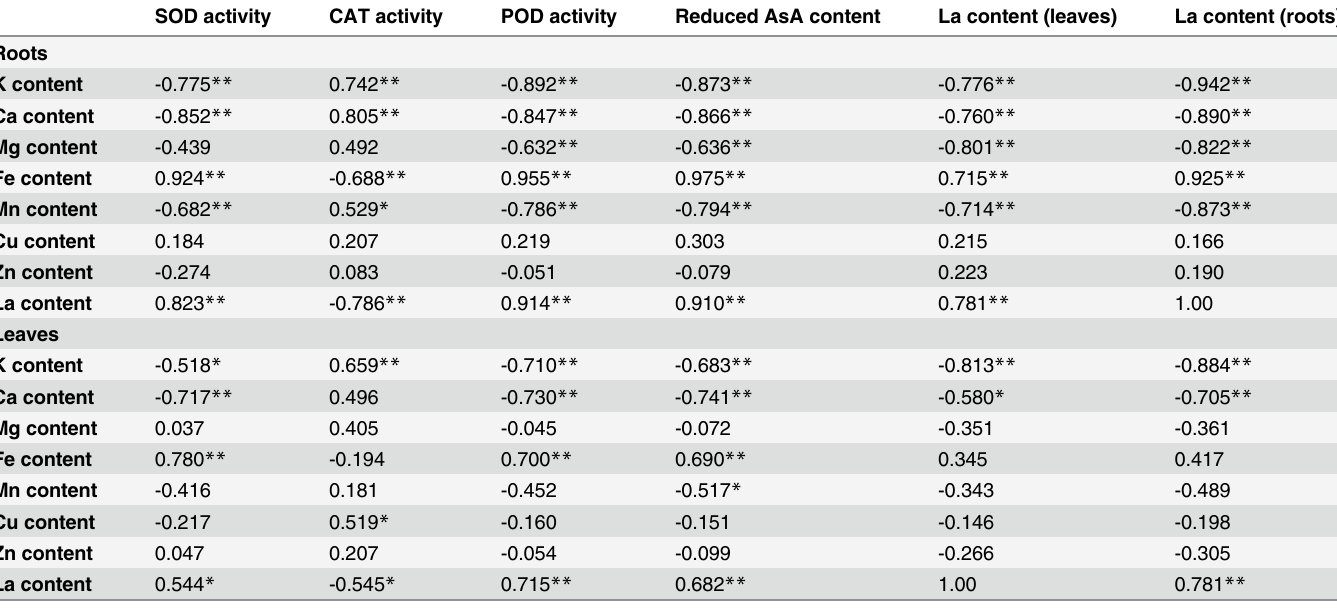
Table 6. Correlation coefficients between antioxidant system activities and metal contents in soybean treated with La 3+ and AR. SOD